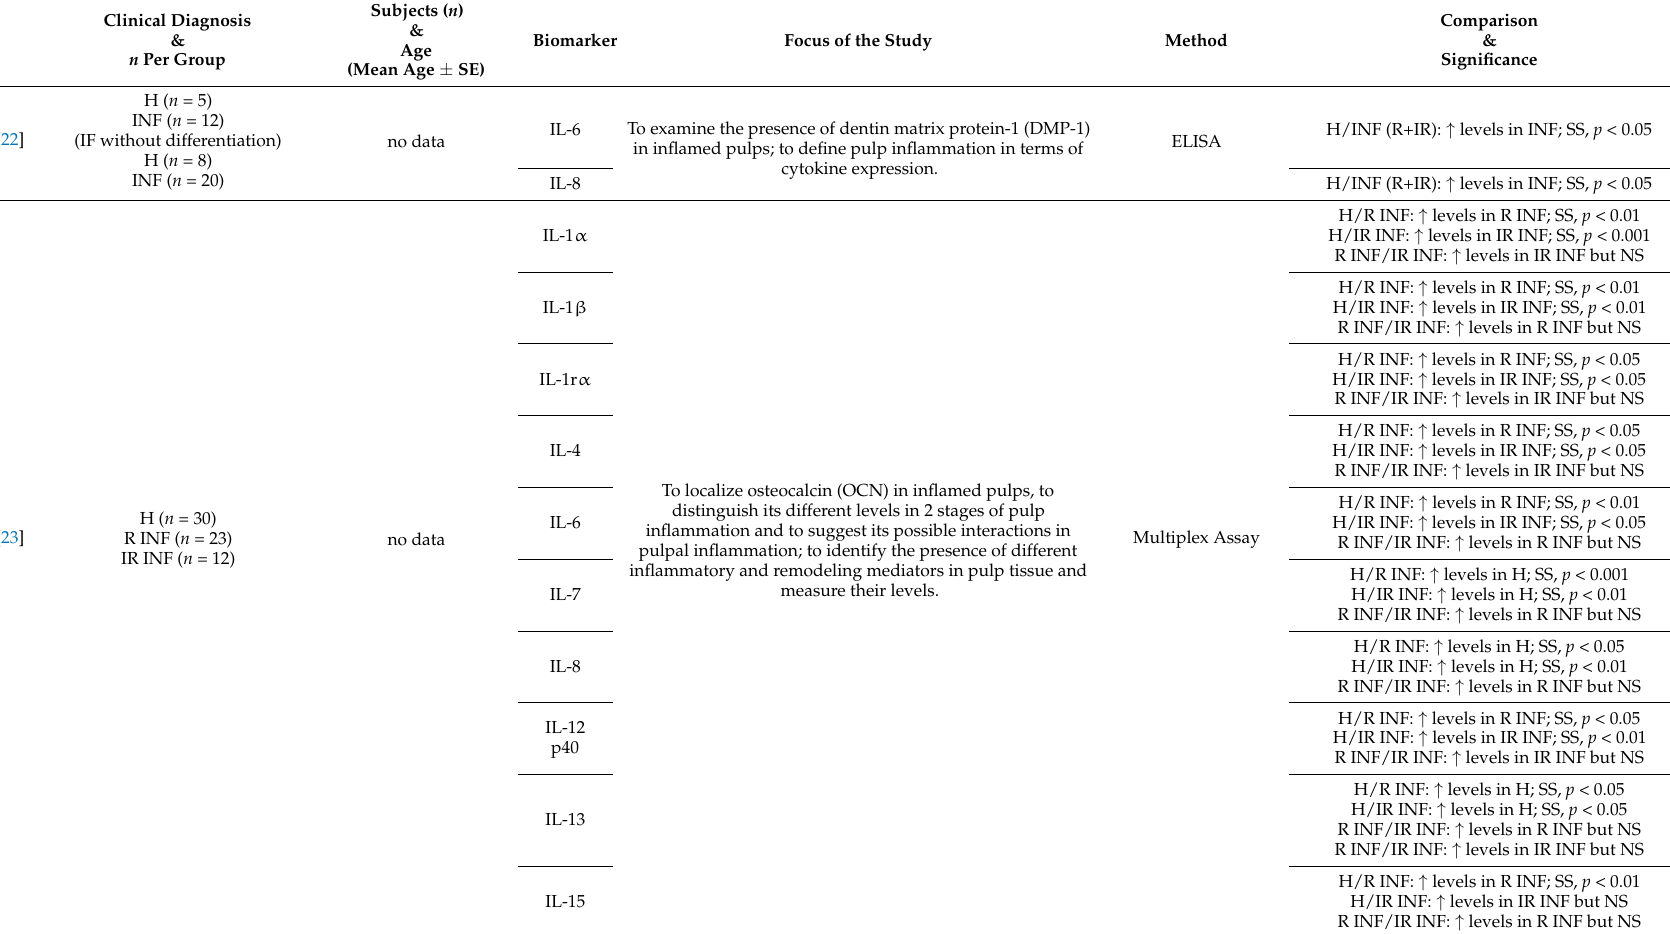
Table 1. Studies included in the present systematic review analysing the presence of IL and MMPs in human dental